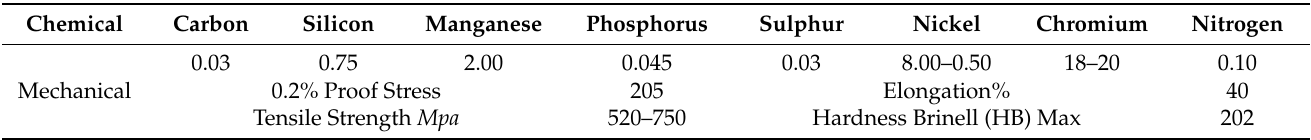
Table 1. Chemical and mechanical properties of AISI 304L in wt%.